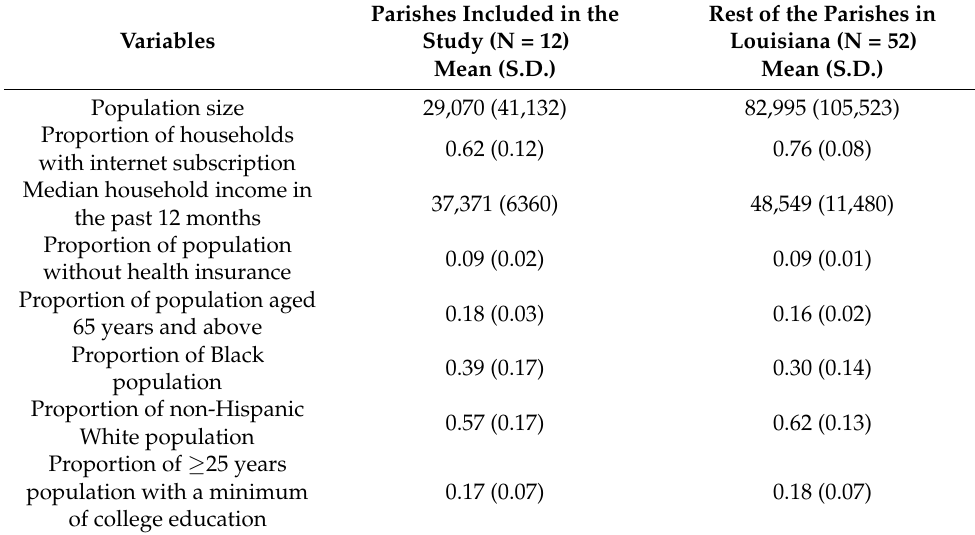
Table 1. Characteristics of parishes in Louisiana.